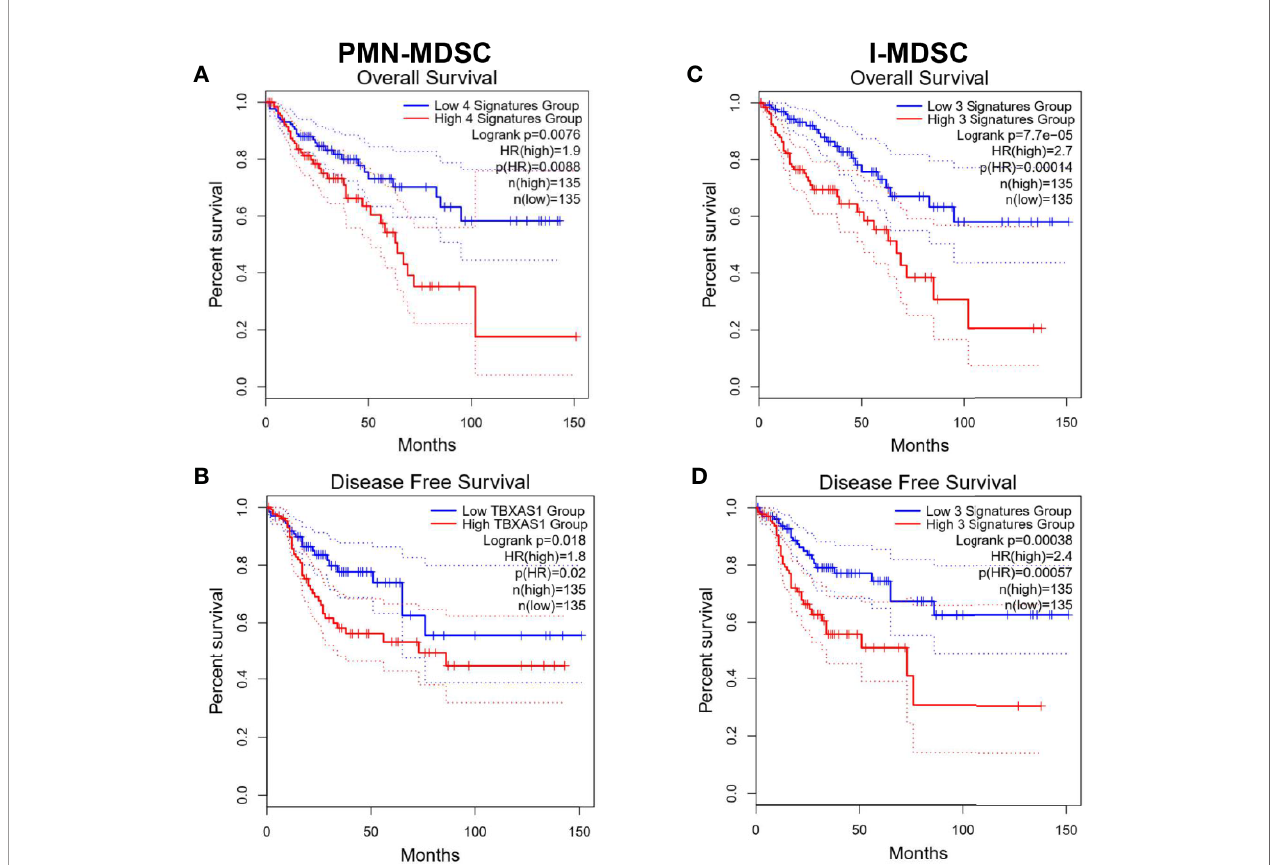
FIGURE 6 | Kaplan-Meier curves for overall survival and disease-free survival according to the identi fi ed gene signatures in tumor-in fi ltrating PMN-MDSCs and I- MDSCs. Patients were divided into high and low groups based on median gene expression. Kaplan-Meier curves illustrate the duration of overall survival (OS) (A , C) and disease-free survival (DFS) of 270 patients (B , D) according to the expression of identi fi ed gene signatures in cohorts of patients in the Cancer Genome Atlas (TCGA) colorectal adenocarcinoma dataset. The Log-rank test was used for curve comparison. The survival signature score is calculated by mean value of log 2 (TPM7nbsp;+ 1) of each